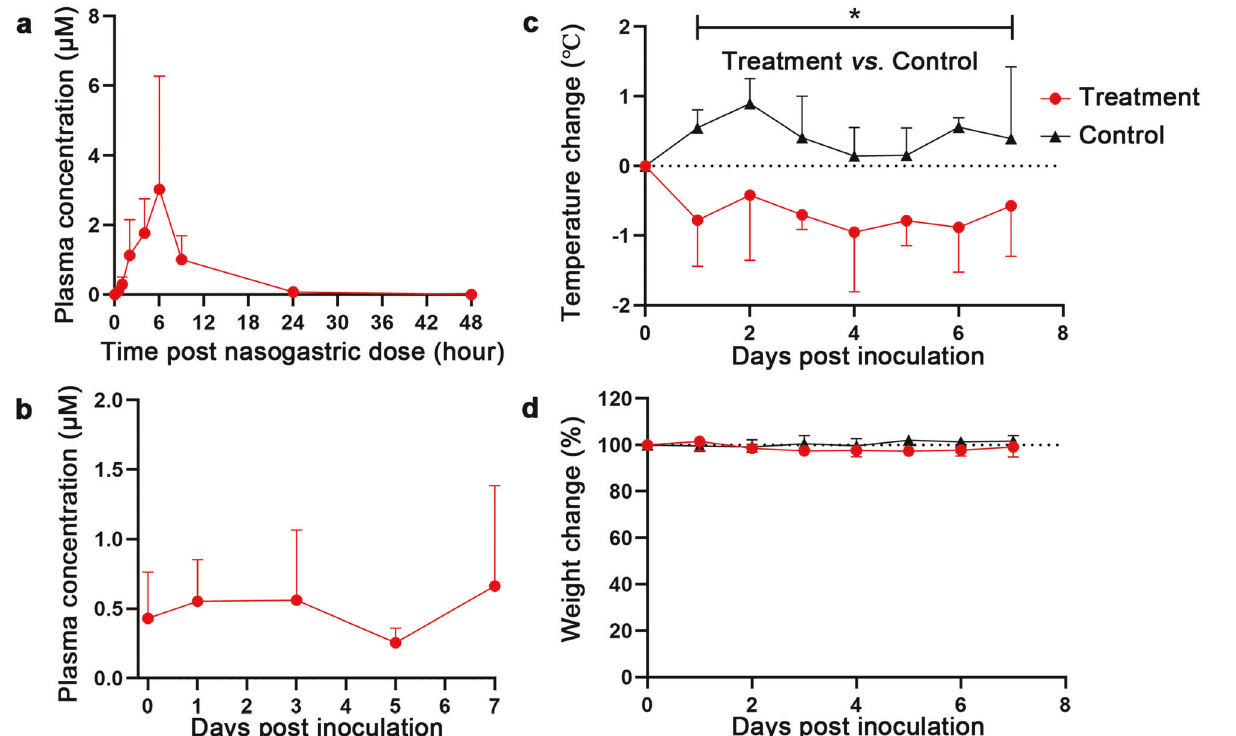
Fig. 1 Nel fi navir plasma exposure and clinical bene fi ts in rhesus macaques inoculated with SARS-CoV-2. a Plasma concentrations of nel fi navir in two healthy rhesus macaques plotted versus time (hours). b Concentration of nel fi navir measured in blood plasma in three rhesus macaques infected with SARS-CoV-2 strain 20SF107. Blood samples were collected 5 h after nel fi navir administration at 0, 1, 3, and 7 dpi, and before nel fi navir administration at 5 dpi, respectively. c , d Temperature ( c ) and body weight ( d ) changes in SARS-CoV-2 infected rhesus macaques treated with nel fi navir. SARS-CoV-2 strain 20SF107 was inoculated into two groups of three rhesus macaques, among which one group was nasogastric administered 5 mL/kg vehicle solution (0.5% CMC-Na; vehicle control; black triangles) and the other group was administered 200 mg/kg nel fi navir starting 1 day before inoculation (prophylactic nel fi navir; red circles). After inoculation, the animals were observed once daily for temperature and body weight changes. Asterisks indicate statistically signi fi cant difference in a mixed ANOVA between the vehicle control and prophylactic nel fi navir groups. * P <